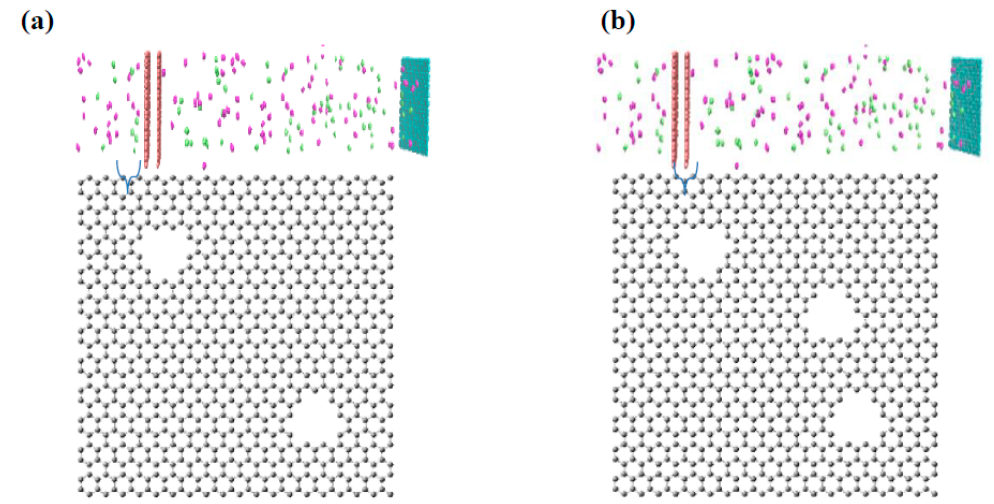
Figure 2. ( a ) Simulation organization and structure of each one of NPG layer with pore density 5%; ( b ) simulation organization and structure of each one of NPG layer with pore density 8%.